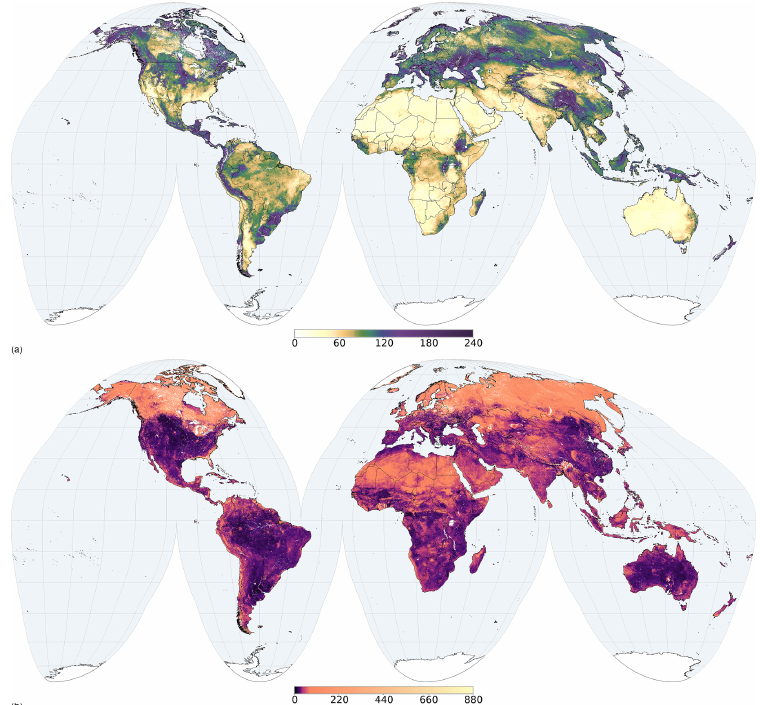
Figure 8. Median total nitrogen prediction (cg/kg) and associated uncertainty for the 15 to 30cm depth interval, (a) for prediction and (b) for